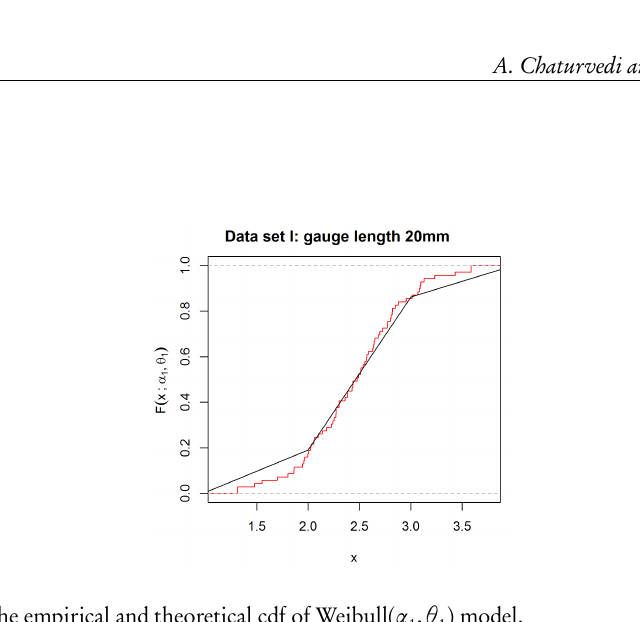
Figure 8 – The empirical and theoretical cdf of Weibull ( α